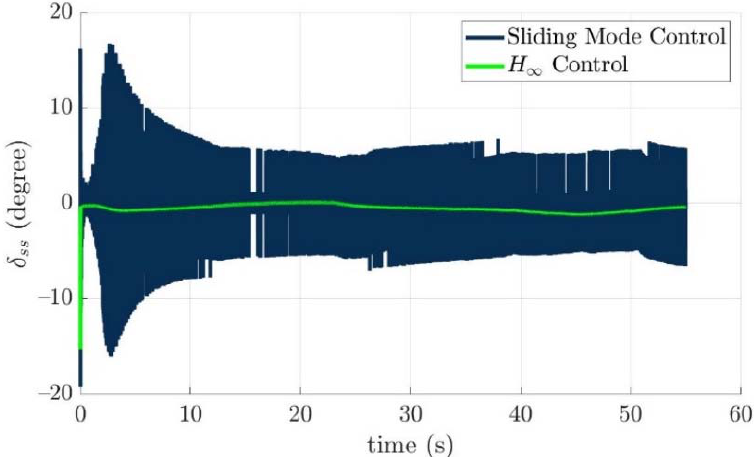
Figure 21. The port stern fin angles of the controlled torpedo-like underwater vehicle for two control laws, respectively.